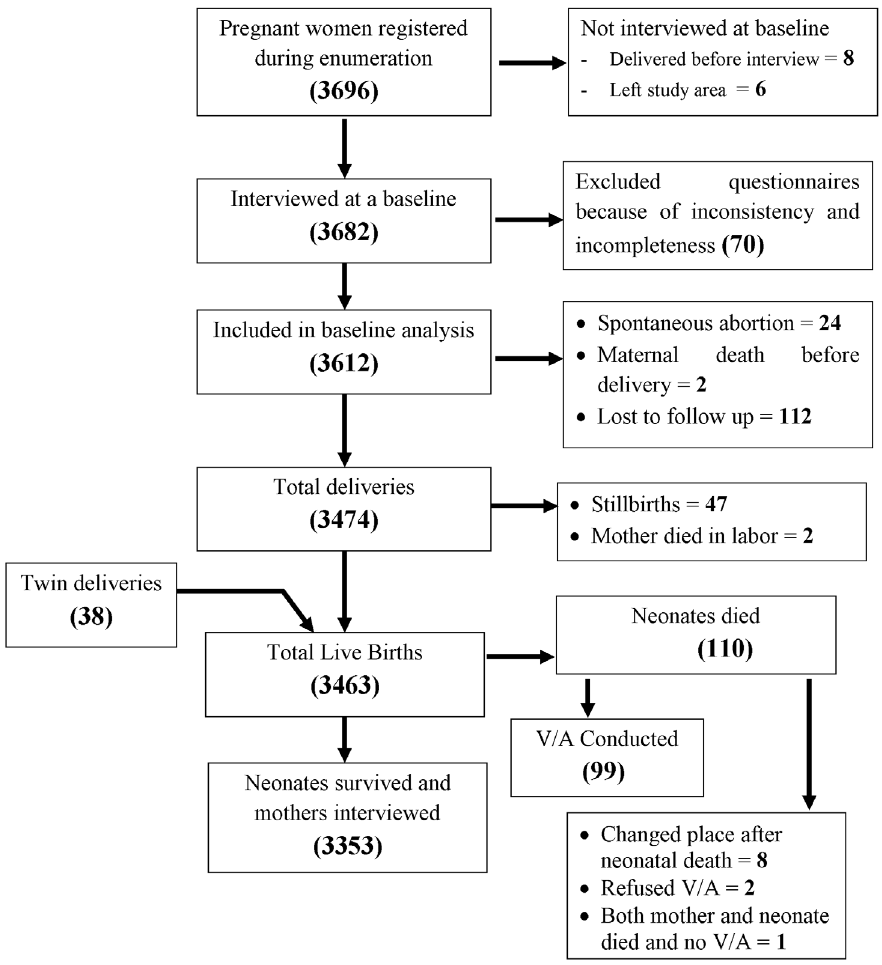
Figure 1. Flow-diagram of the overall study process, Jimma Zone, Southwest Ethiopia, Sept 2012-Dec 2013. This figure shows that a total of 3696 pregnant women were obtained during enumeration. After excluding 14 women because of different reasons, 3682 women were interviewed at a baseline. Again after excluding 70 incomplete and inconsistent questionnaires, 3612 were included in the analysis and enrolled in the follow up. After the follow up, total of 3472 deliveries happened; among which 38 were twins and 47 were stillbirths. From the total of 3463 live births, 110 died before 28 days.